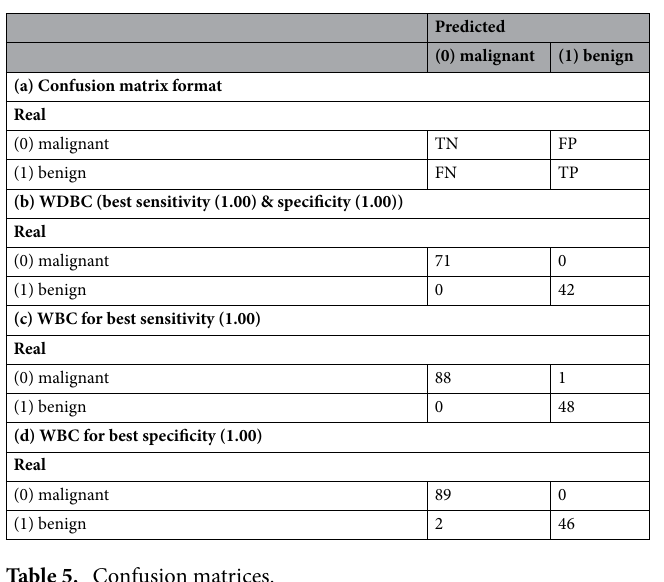
Table 5. Confusion matrices.